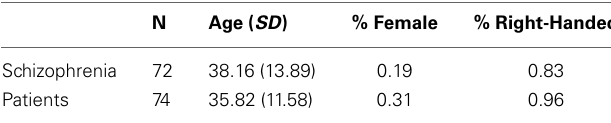
Table 1 | COBRE FCON-1000 data